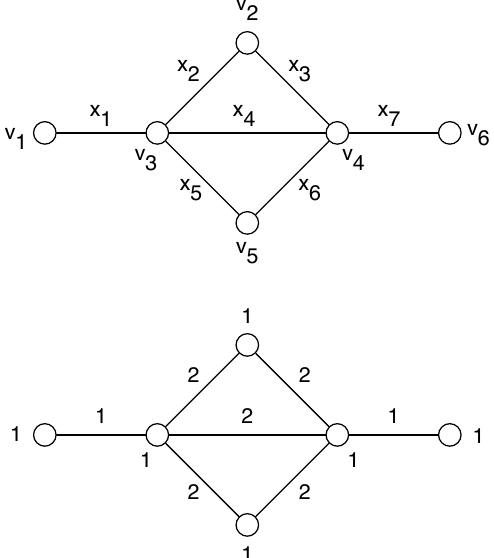
Figure 1: A Z -magic labeling of H with magic value 3